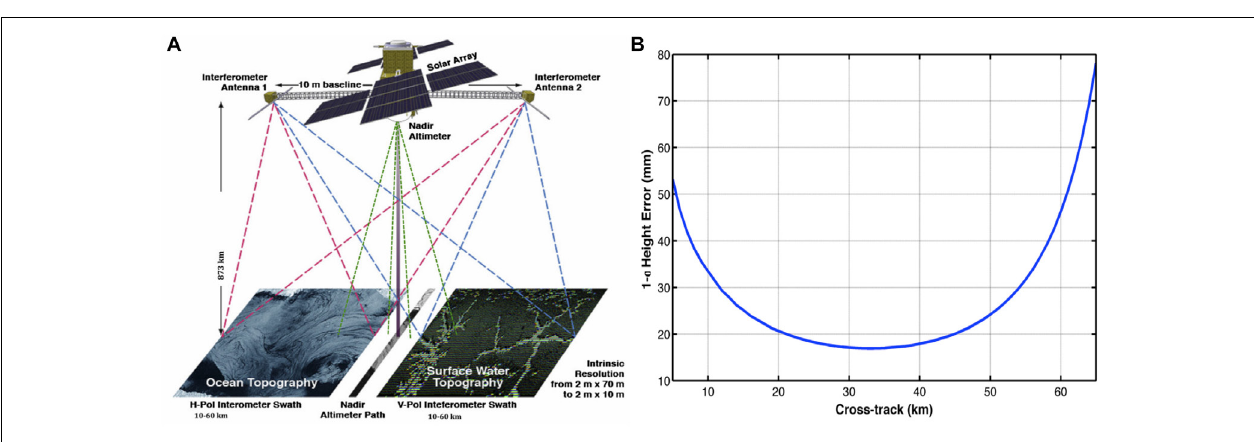
FIGURE 2 | (A) Schematic of the SWOT measurement technique using the KaRIn instrument for SAR-interferometry over the two swaths, and a Jason-class nadir altimeter in the gap. (B) The standard deviation of the ocean height error performance at 1 km × 1 km due to all the random errors (in mm) as a function of distance across the swath for a 2-m significant wave height. The swath-averaged (10 to 60 km) height error is 2.4 cm ( Credits: NASA-JPL